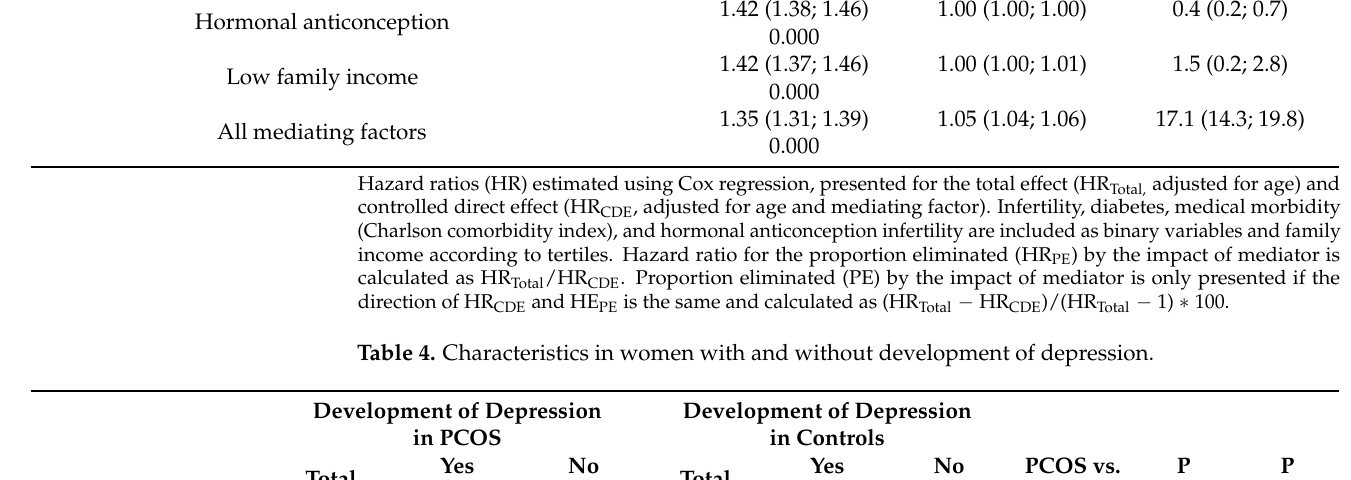
Table 4. Characteristics in women with and without development of depression.